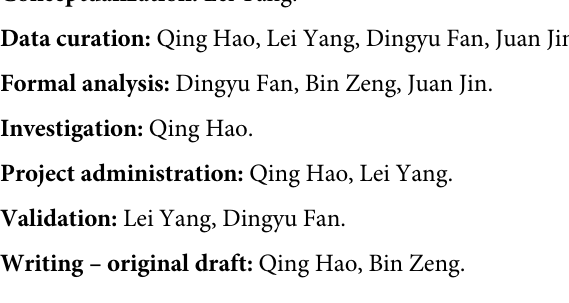
S2 Table. The list of the DE lncRNAs. S3 Table. The common DElncRNAs among the four comparisons. S4 Table. The putative cis-target genes of the DE lncRNAs. S5 Table. The list of the DEGs. S6 Table. The list of DElncRNAs and corresponding putative cis-target DEGs. S7 Table. The functional analyses of cis-target DEGs of DE lncRNAs from HR1 VS HR0. S8 Table. The functional analyses of cis-target DEGs of DE lncRNAs from HR3 VS HR0. S9 Table. The functional analyses of cis-target DEGs of DE lncRNAs from HR5 VS HR0. S10 Table. The functional analyses of cis-target DEGs of DE lncRNAs from HR7 VS